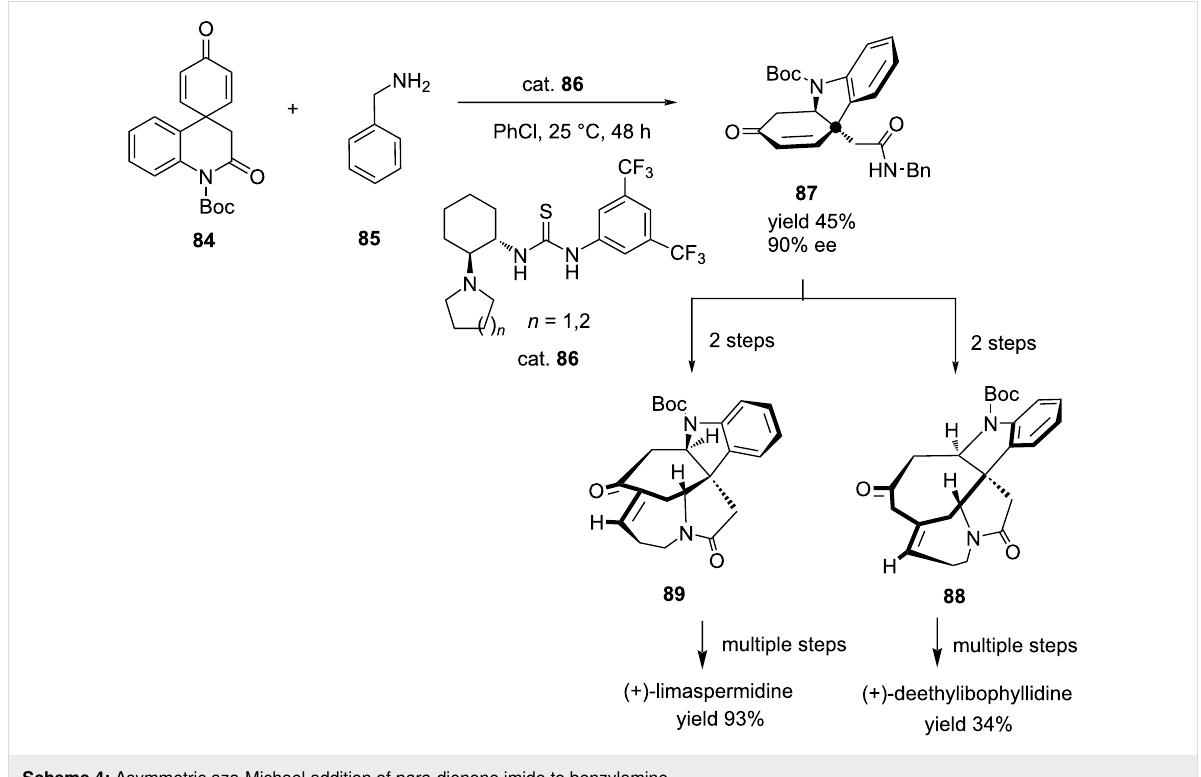
Table 20: Intramolecular aza-Michael addition reaction catalyzed by chiral phosphoric acid.